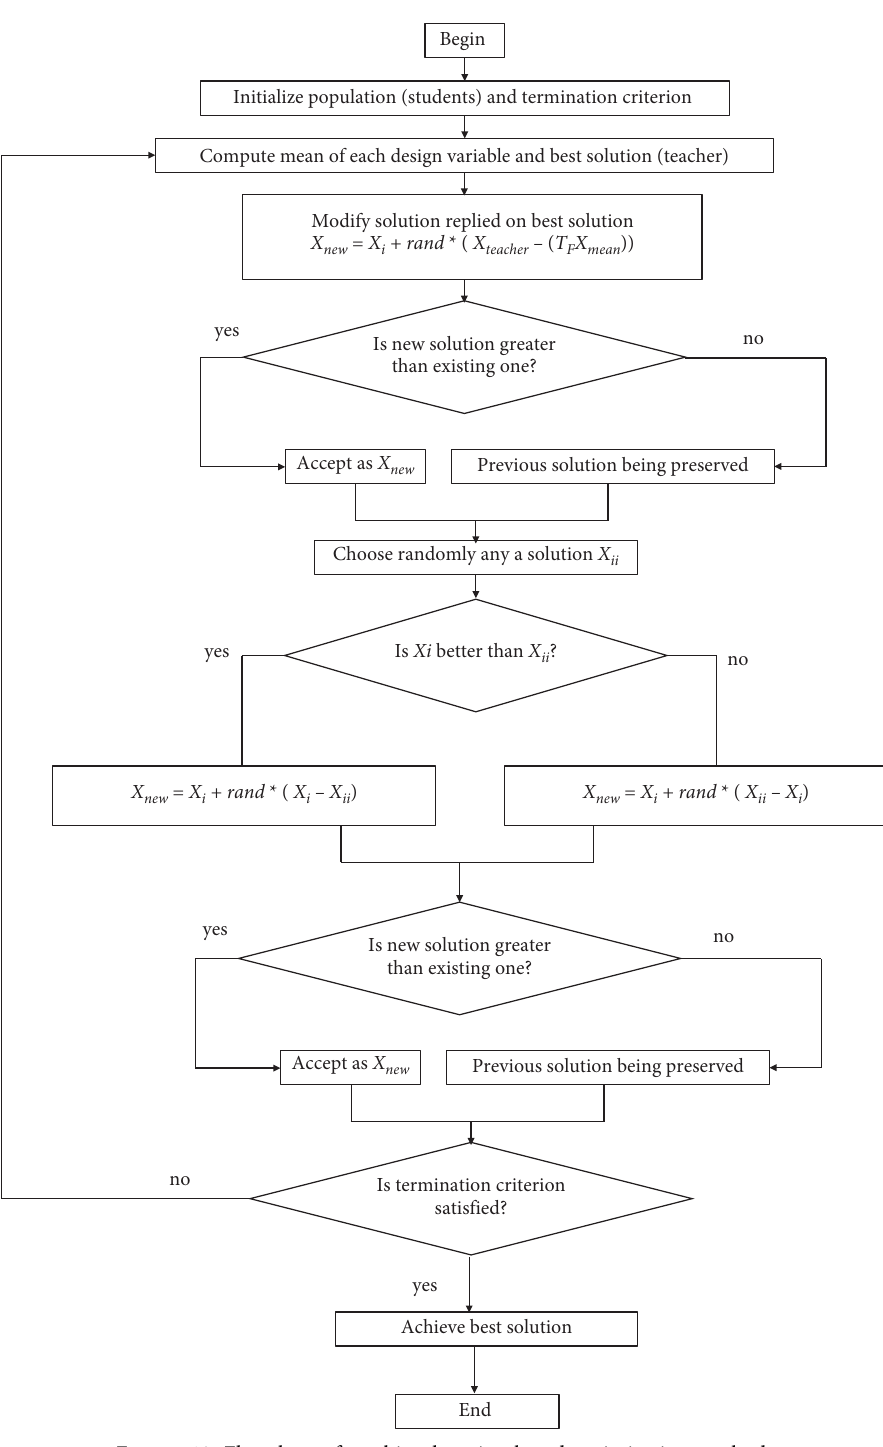
Figure 12: Flowchart of teaching-learning-based optimization